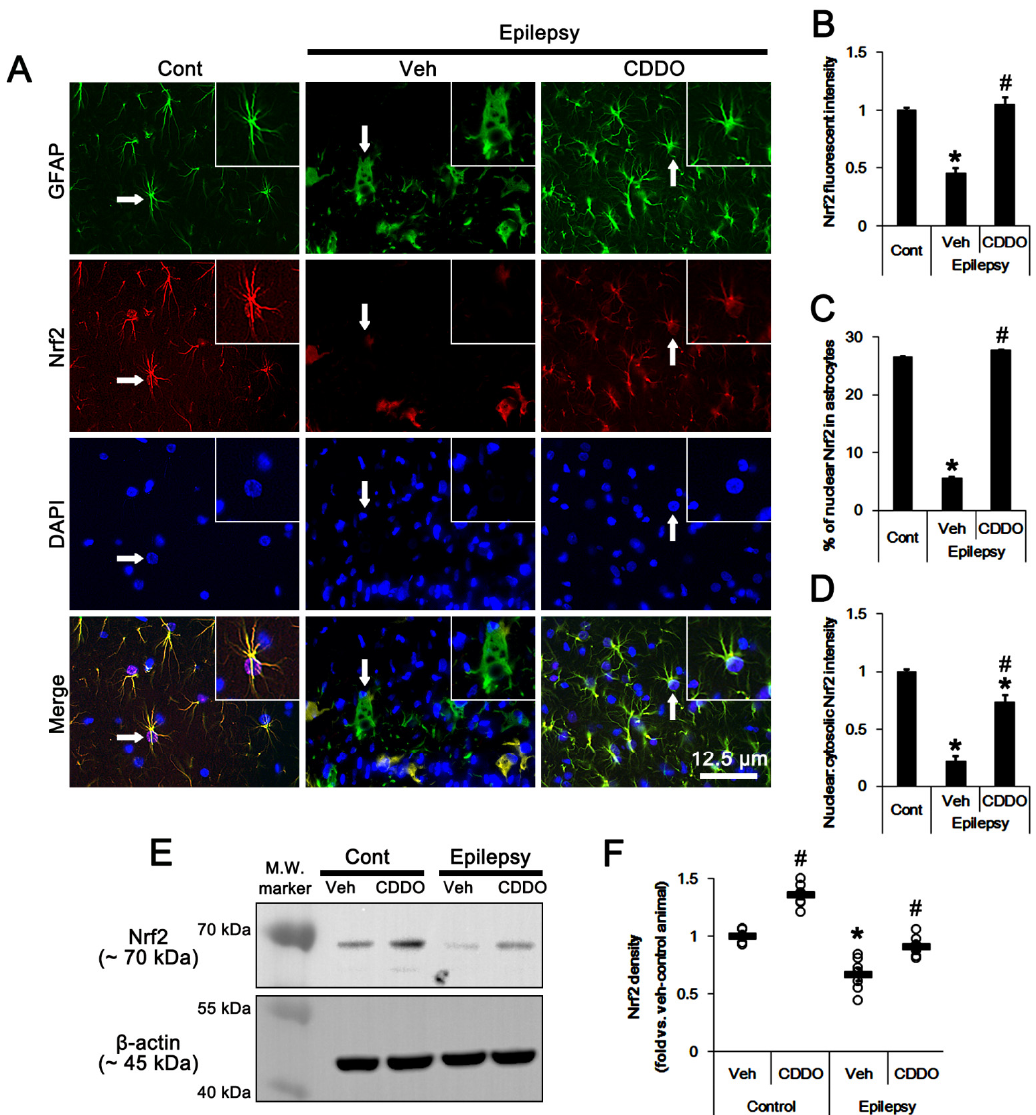
Figure 1. Effects of CDDO-Me on nuclear factor-erythroid 2-related factor 2 (Nrf2) expression and its nuclear accumulation in CA1 astrocytes of control and epileptic rats. As compared to control animals (Cont), Nrf2 expression and its nuclear accumulation were reduced in CA1 astrocytes in epileptic rats. CDDO-Me increased Nrf2 expression and its nuclear accumulation in CA1 astrocytes, as compared to vehicle (Veh). ( A ) Representative photos demonstrating astroglial Nrf2 expression in CA1 astrocytes. Arrows indicate the inserted magnification photos. ( B – D ) Quantifications of Nrf2 expression ( B ), the fraction of astrocytes showing Nrf2 signals in total astrocytes ( C ) and the ratio of nuclear:cytosolic Nrf2 intensity ( D ) in CA1 astrocytes. Error bars indicate SEM (*,# p < 0.05 vs. control and vehicle-treated epileptic rats, respectively; n = 7). ( E ) Representative Western blot for Nrf2 in the CA1 region. ( F ) Quantitative values (mean ± SEM) of the Western blot data concerning Nrf2 expression level ( n = 7, respectively). Open circles indicate each value. Horizontal bars indicate the mean value. Significant differences are *,# p < 0.05 vs. control animals and vehicle-treated